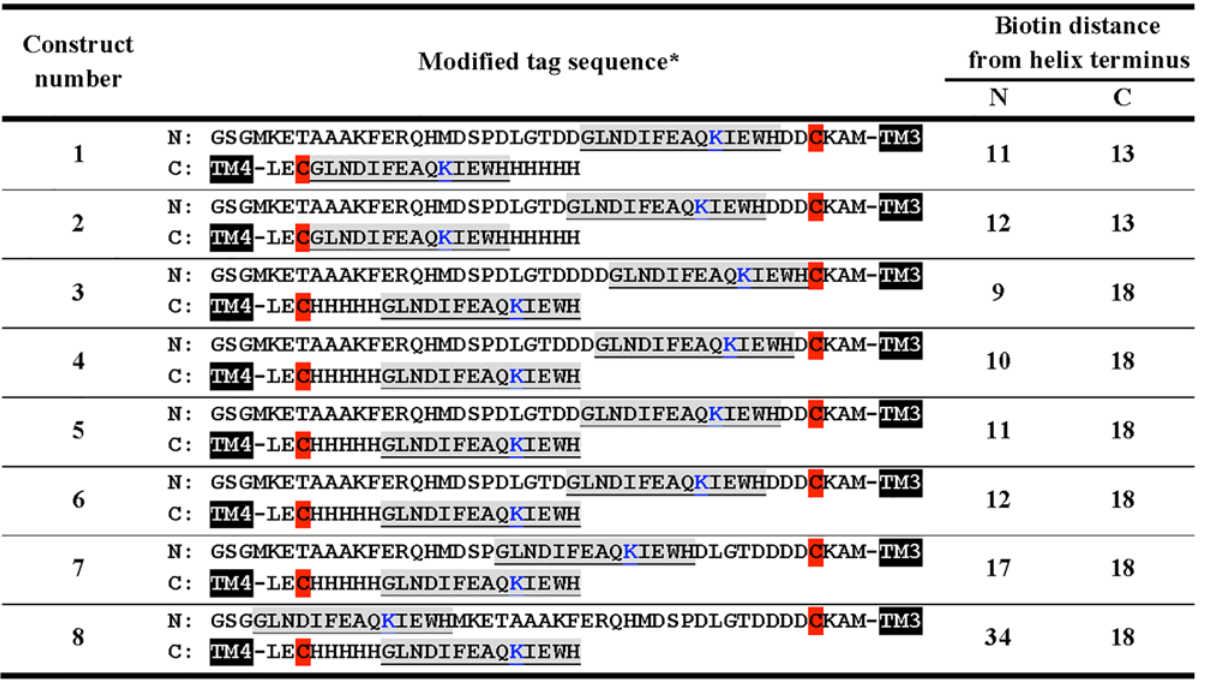
Fig 1. Human CFTR TM3/4 sequence designs with varying biotinylation site positions. * TM3/4 – 2C constructs were engineered to contain a biotinylation sequence (rendered in gray, with interactive Lys residue shown in blue) at various distances from each of the two helix-terminal Cys residues. The two Cys residues in each construct are highlighted in red. Only the tag sequences are shown; the solid TM3 and TM4 blocks indicate the adjacent transmembrane segments. For the full TM3/4 hairpin sequences, see the Materials and Methods section.